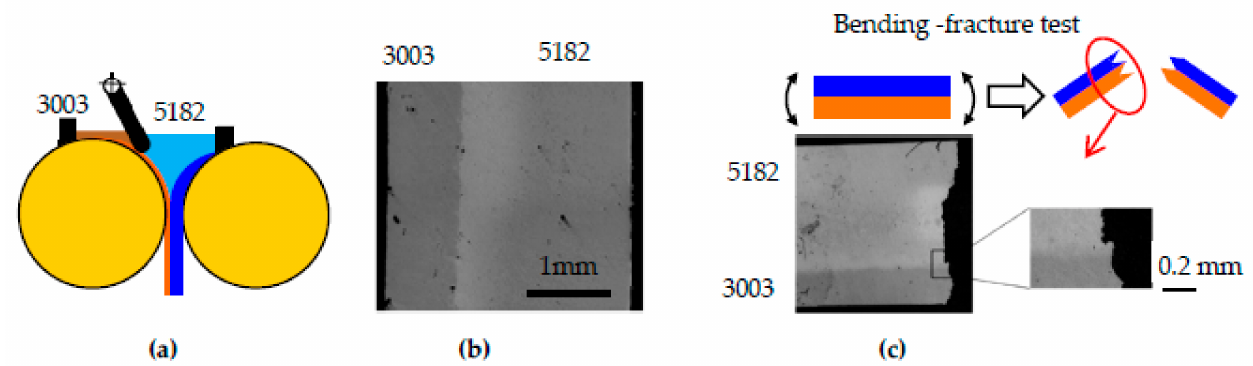
Figure 22. Cross-section of clad strip consisting of 3003 and 5182 aluminum alloys. ( a ) Schematic illustration showing the 3003 alloy as the base strip and the 5182 alloy as the overlay strip. ( b ) Cross-section of clad strip. ( c ) Result of bending-fracture